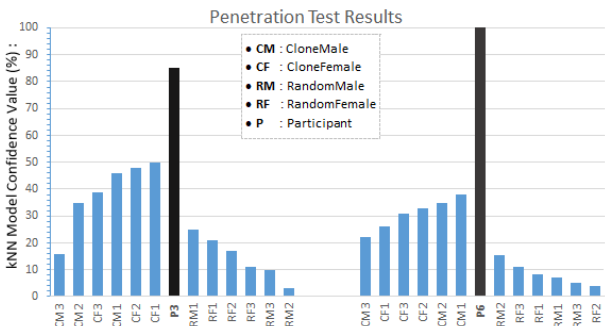
Figure 8. WhiteBox Penetration Test: Attackers mimicking the tasks performed by the valid Participants P3 and P6 in an attempt to breach the security of the BioMove identification system. Results indicate different level of confidence values shown above. Attackers with similar physical features to the valid users have higher confidence values.